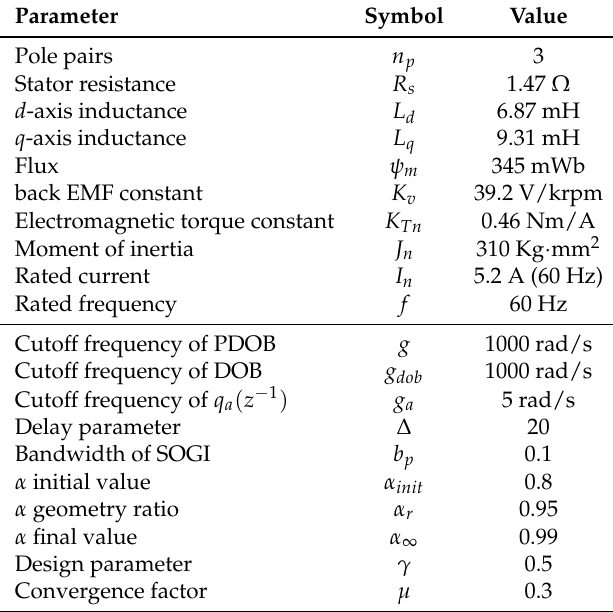
Table 3. Experimental